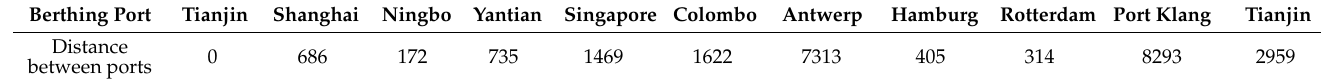
Table 6. Distance between berthing ports on this route. Unit: NM.